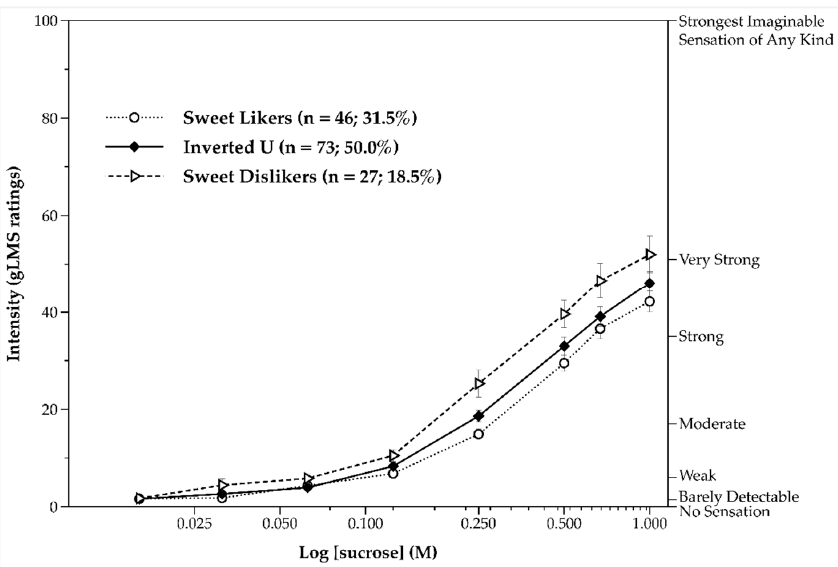
Figure 3. Liking ratings (mean ± standard error of the mean) as a function of sucrose solutions by the three sweet taste liker phenotypes. Ratings were averaged across the two taste test blocks. The response pattern for the sweet liker phenotype is displayed with a dotted line, the response pattern of inverted U-shaped phenotype with a solid line, and the response pattern of sweet disliker phenotype with a dashed line. Different colors denote the different ranges of liking ratings for 1 M sucrose which, according to the relevant sensitivity and specificity checks (see Tables 2 and 3 for details), could be used for the reliable discrimination between the three distinct sweet taste liker phenotypes: green color corresponds to the range of liking ratings for 1 M sucrose representing sweet likers, yellow color indicates the hedonic response spectrum to 1 M sucrose characteristic of the inverted U-shaped phenotype, and red color corresponds to the range of liking ratings for 1 M sucrose for sweet dislikers.